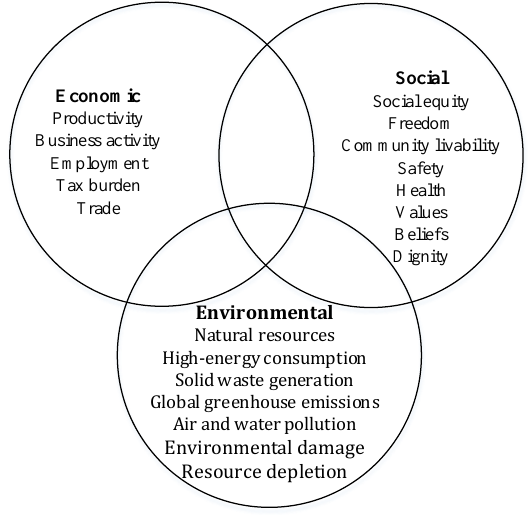
Figure 1. Three dimensions of SDGs for sustainable development of transportation.